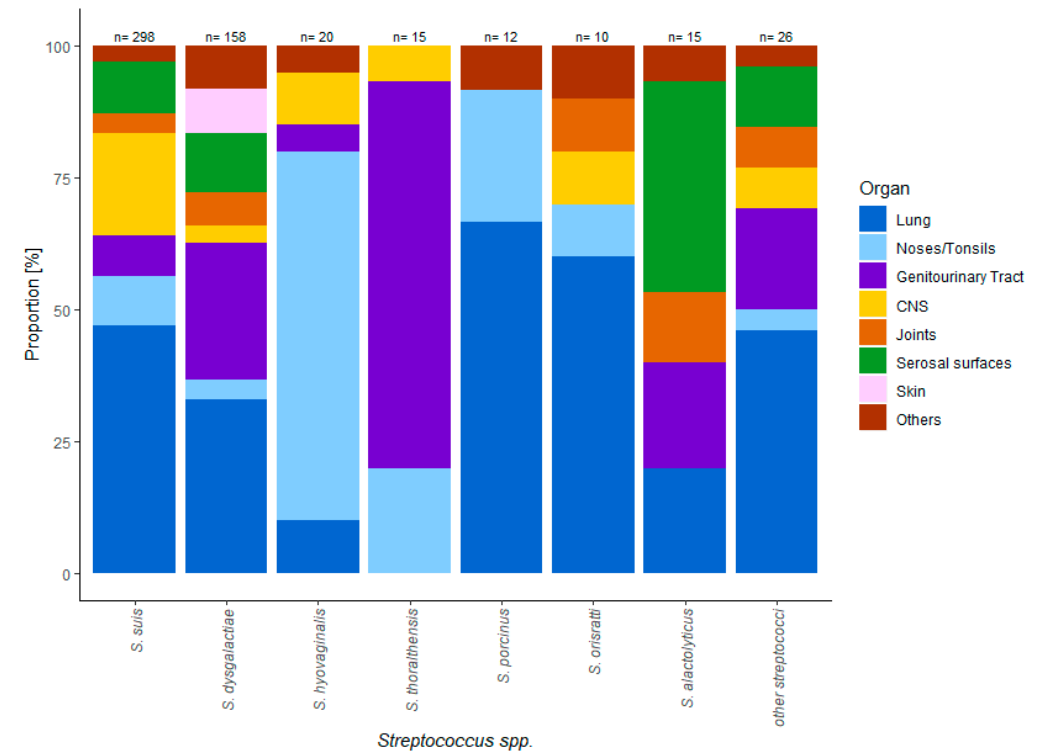
ff erent Streptococcus spp.